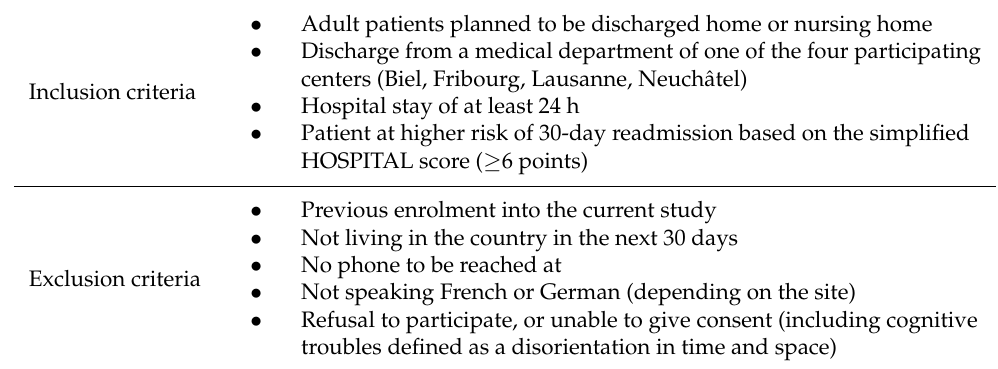
Table 2. Inclusion and exclusion criteria.